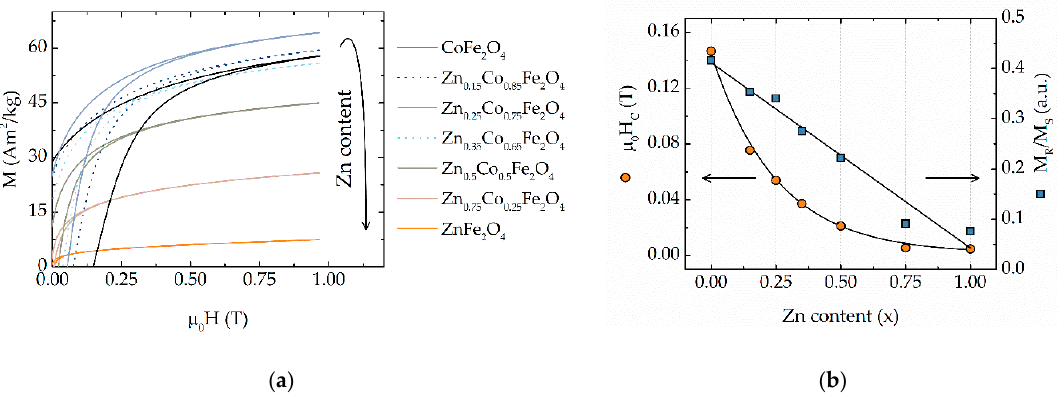
Figure 2. ( a ) The first quarter of M-H hysteresis cycles recorded at 300 K of CoFe 2 O 4 nanoparticles doped with Zn. The arrow indicates the trend of M S ; ( b ) Dependence of coercivity H C and reduced remanence M R / M S versus Zn-content. Materials 2020 , 13 , x